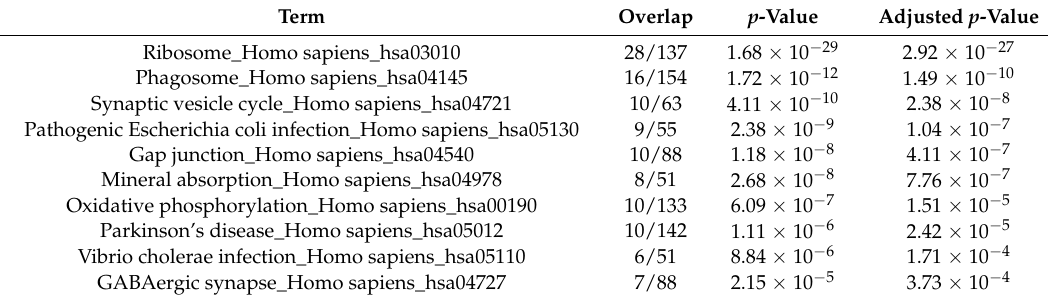
Table 4. Top ranked 10 KEGG pathways enriched in 244 identified gene